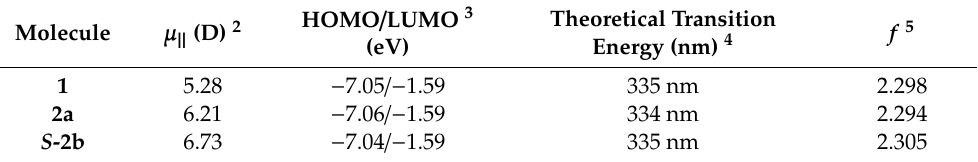
Figure 2. Optimized molecular geometries as well as frontier molecular orbital distributions for 1 , 2a , and S - 2b calculated by density functional theory at the M06-2X / 6-31 + G(d) level. Table 1. Results of quantum chemical calculations.